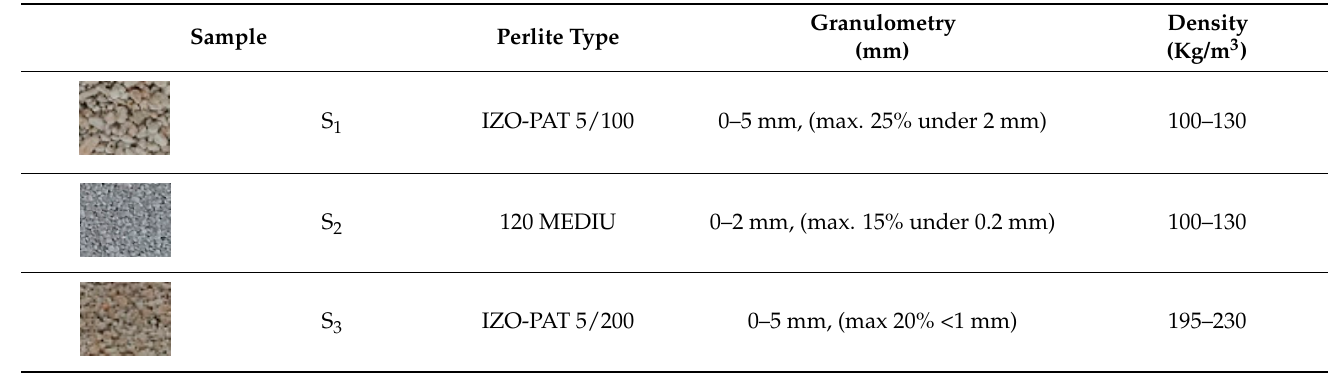
Table 1. Expanded perlite types.